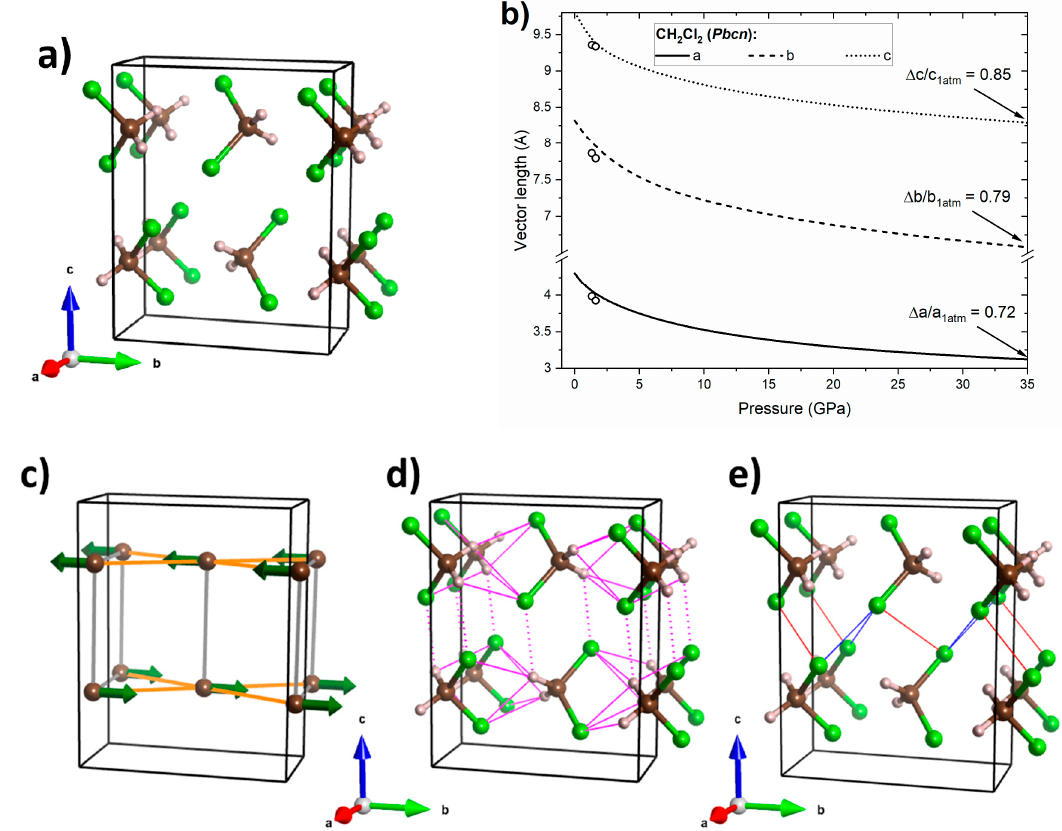
Figure 7. ( a ) Crystal geometry of CH 2 Cl 2 in the Pbcn structure at 32 GPa, where brown / grey / green balls mark C / H / Cl atoms, respectively; ( b ) calculated pressure dependence of the lattice vectors of the this structure (black lines) together with experimental data from ref. [31] (open circles); ( c ) interactions between molecular dipoles (green arrows), where those energetically favourable are shown in orange and unfavourable ones in grey; ( d ) network of hydrogen bonds (magenta lines), where those connecting molecules within the ab plane are indicated by full lines and dotted lines indicate interactions primarily along the c vector; ( e ) Cl ··· Cl interactions with type II interactions shown in blue and type I interactions in red.